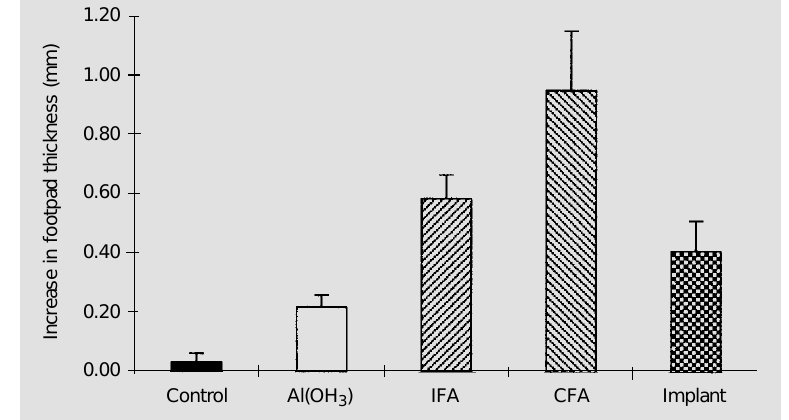
Figure 2 - Cellular immune response elicited by Ova-conjugated implanted sponges. Swiss mice were immunized with Ova in Al(OH) 3 (10 µg, ip ), complete Freund’s adjuvant (CFA) (100 µg, sc ) or incomplete Freund’s adjuvant (IFA) (100 µg, sc ), or were implanted subcuta- neously with Ova-coupled sponges. Controls were either injected with 10 µg of Ova in saline, ip , or implanted with sponges treated without Ova. During week 3, mice were injected subcutaneously with 30 µl of either 2% aggregated Ova (left footpad) or PBS (right footpad). Data are reported as the difference in thickness (mean ± SEM, N = 5-7) between both footpads observed 48 h after